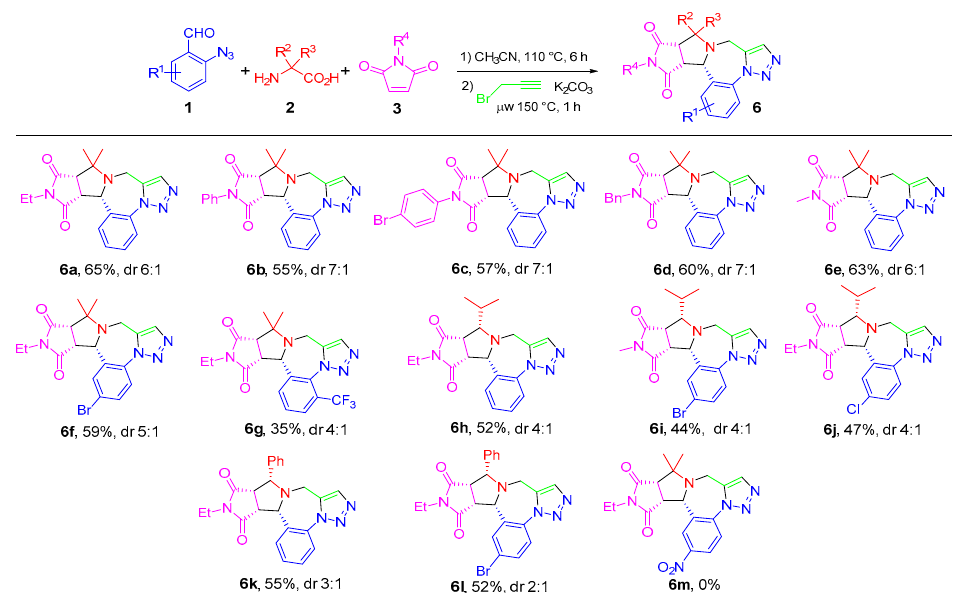
Table 4. One-pot synthesis of triazolobenzodiazepines 6 a .